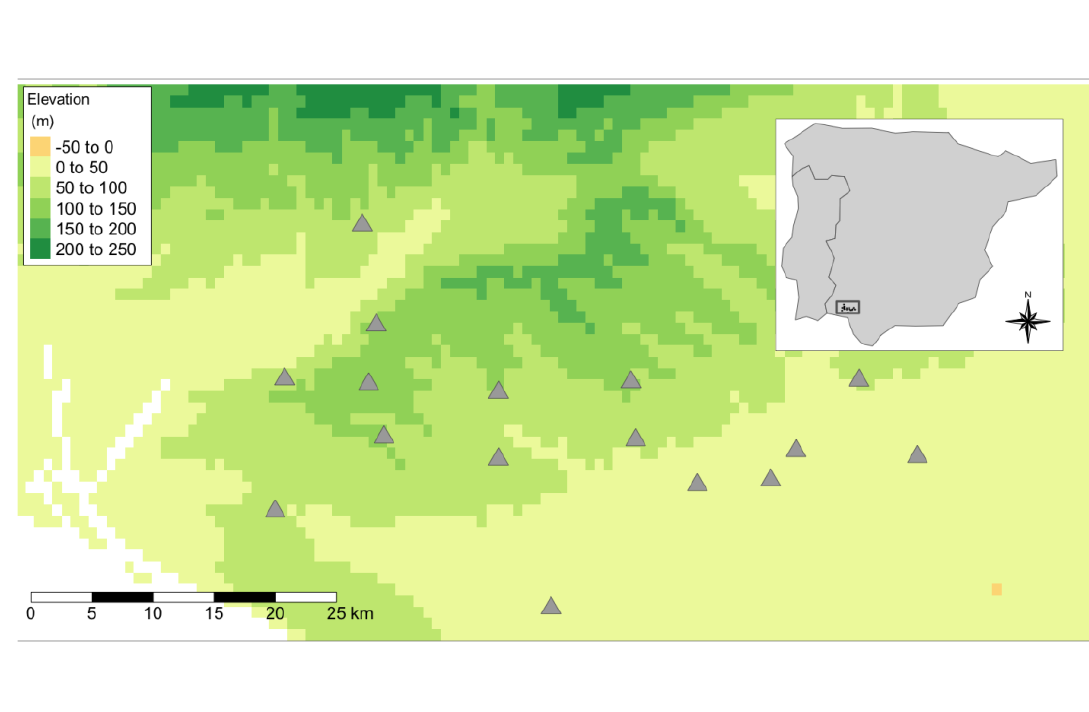
Figure S1. Map showing location of 16 Mediterranean woodland patches where plant-pollinator interactions were surveyed from February to May 2015. Inset shows location of study area within SW Spain.